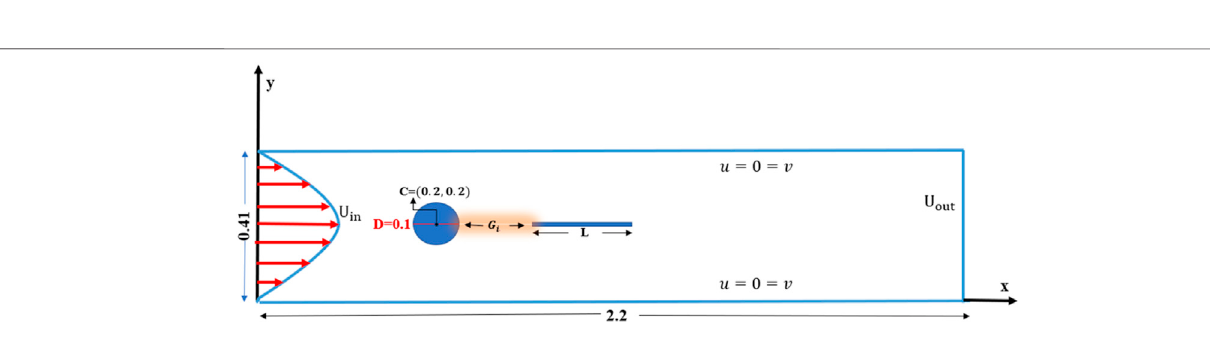
FIGURE 1 | Schematic diagram, when a splitter of length L i , where i (cid:1) 1 , 2 , and 3 is attached to the cylinder.